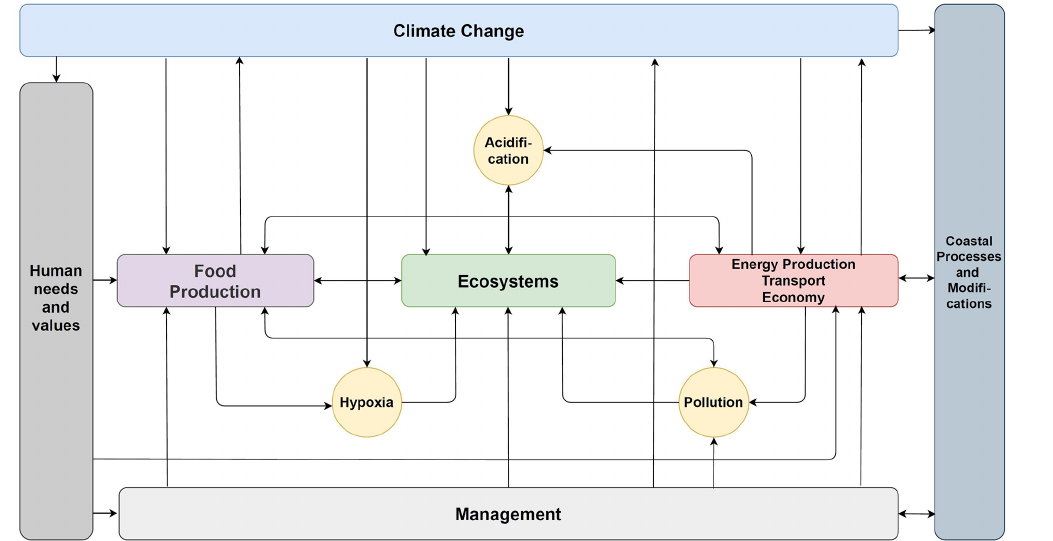
Figure 5. Schematic view of the interrelations between the different factors. Food production includes land use, agriculture and nutrient loads, aquaculture, and fisheries. Energy production, transport and economy include offshore wind farms, shipping and tourism. Coastal processes and modifications include coastal processes, submarine groundwater discharges and river regulations. Ecosystems include non-invasive species. Pollution includes contaminants, dumped military material and marine litter. Management includes technological approaches (Mar- cus